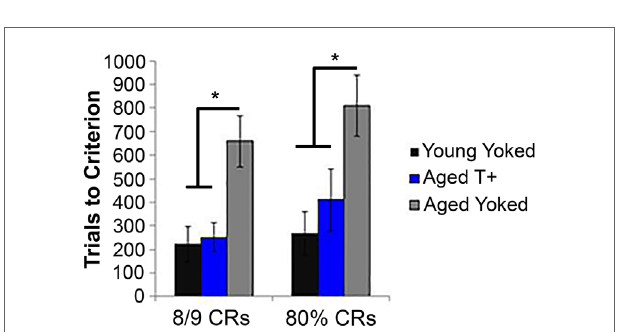
FiGURe 3 | Average number of trials to reach the late learning criteria (8/9 CRs and 80% CRs) for young yoked controls, aged T + triggered, and aged yoked control animals . Aged yoked controls required more trials to reach both criteria than young yoked controls, indicating disrupted performance in aged animals. Aged animals trained under T + conditions performed better than their yoked control counterparts and showed no difference from the young yoked controls. Thus, theta-contingent training alleviated the cognitive deficits seen in aged controls. * p < 0.05. Figure adapted from data published in Asaka et al. (149).